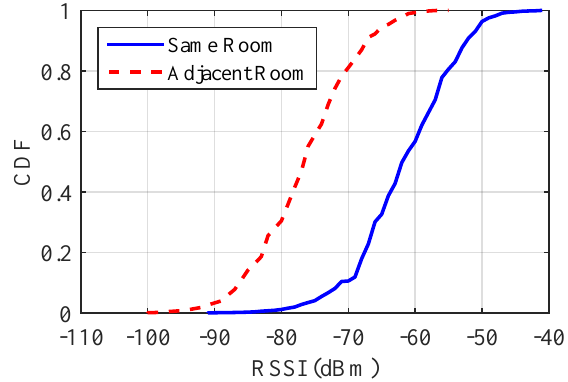
Figure 15. Wireless performance of SPW-2 in the a residential